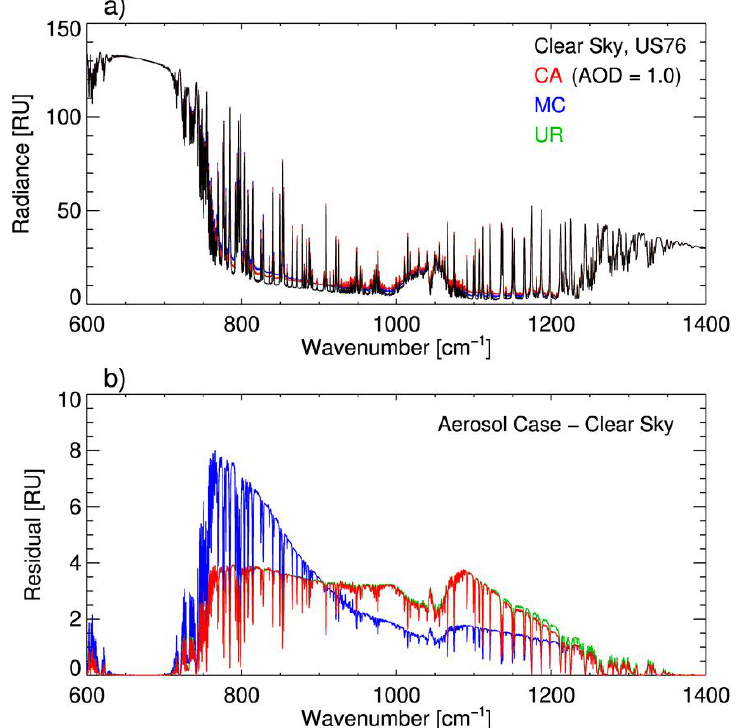
Figure 5. ( a ) The simulated radiance from LBLDIS for clear sky (black) and different mixture aerosol types: CA (red), UR (green), and MC (blue). ( b ) The residual of radiances between clear sky and aerosol cases set as 1.0 of AOD.